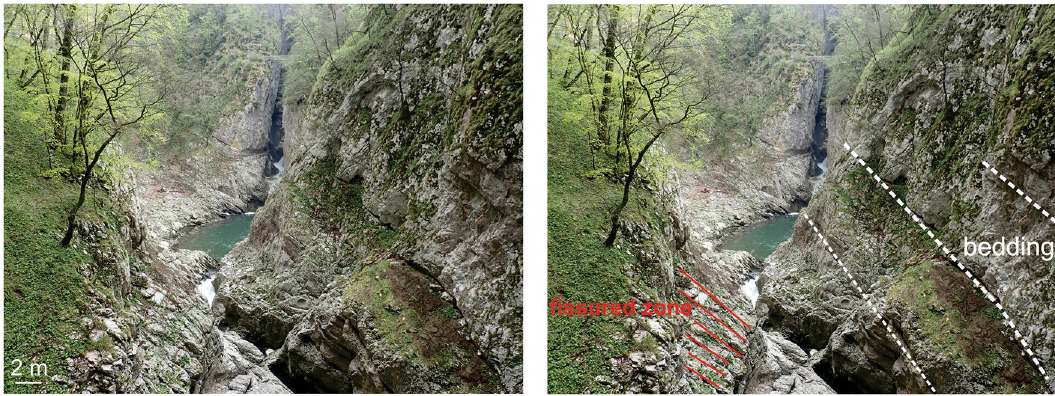
Fig. 5 Bedding planes (dip direction towards the SW and S) and fissured zone (general direction N–S) near the bottom of Velika Dolina. Photo S.